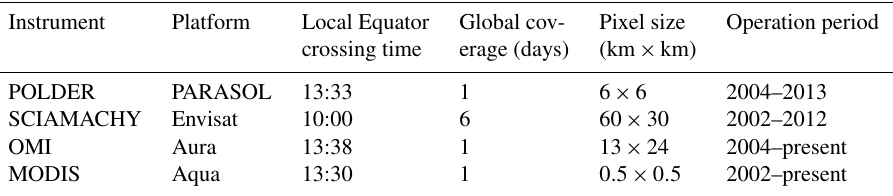
Table 1. Spatial and temporal resolution of the different satellite instruments as used in this paper. Grid sizes of SCIAMACHY and OMI are those at nadir; grid sizes of POLDER and MODIS are fixed. Instrument Platform Local Equator Global cov- Pixel size Operation period crossing time erage (days) (km × km) POLDER PARASOL 13:33 1 6 × 6 2004–2013 SCIAMACHY Envisat 10:00 6 OMI